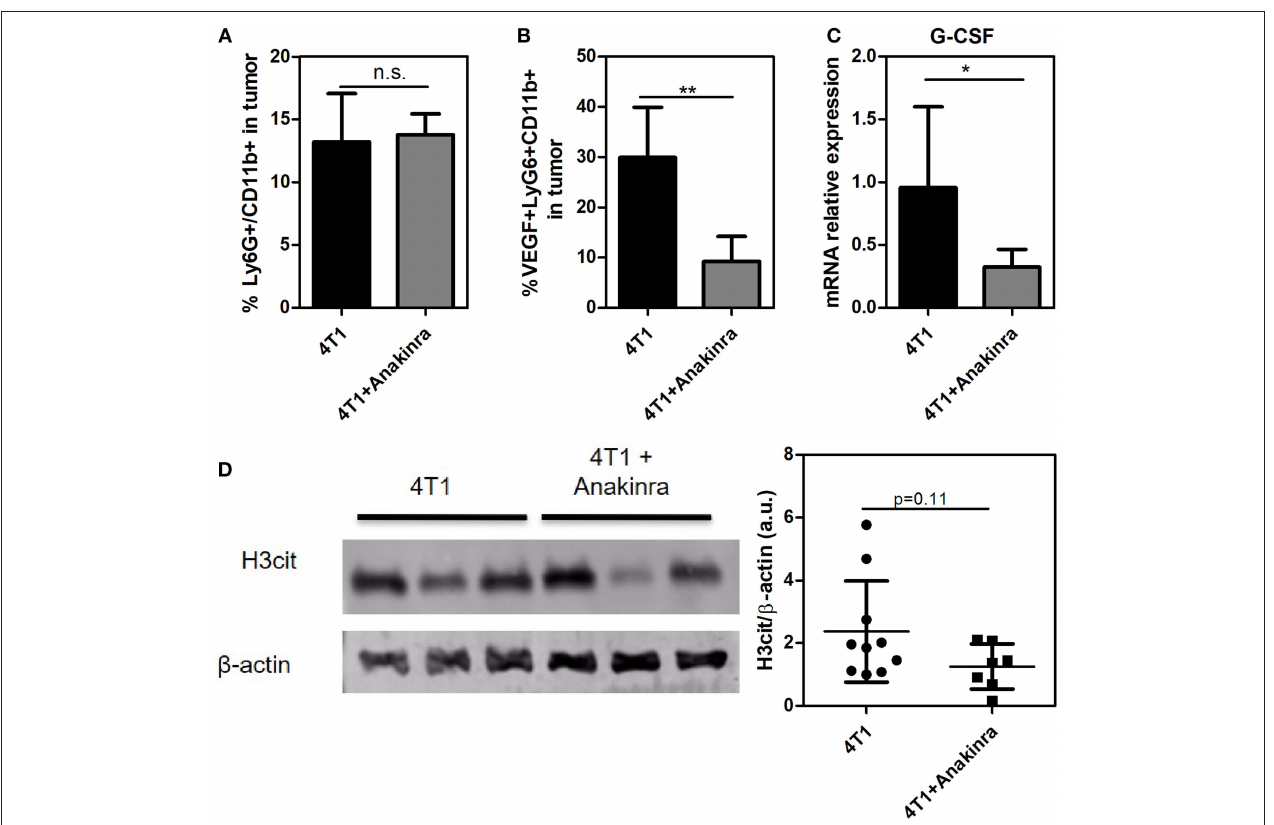
FIGURE 4 | Impact of blocking IL-1R in the 4T1 tumor microenvironment. Both 4T1 and 67NR tumor-bearing mice received anakinra (10 mg/kg/day, s.c.) for 8 between day 14 and day 21 after the tumor cell inoculation. (A) The infiltration of neutrophils into 4T1 ( n = 6) and anakinra-treated 4T1 ( n = 6) tumors was analyzed 21 days after the cell inoculation. The tumors were dissociated into single cells and assessed for Ly6G + CD11b + cells via flow cytometry. (B) The expression of VEGF in tumor-associated neutrophils in the 4T1 tumor (black bars, n = 4) or anakinra-treated 4T1 (gray bars, n = 6) tumors was assessed by VEGF expression in Ly6G + CD11b + cells. (C) The expression of the G-CSF gene was analyzed by qRT-PCR in tumor lysates from 4T1 (black bar, n = 6) and anakinra-treated 4T1 (gray bar, n = 6) tumors. β - actin was used as a reference gene for normalization. The relative expression level of the mRNA was calculated using the 11 CT method. (D) To evaluate the presence of NETs in the tumor microenvironment of mice treated with the IL-1R antagonist, the levels of citrullinated histone (H3cit) in 4T1 ( n = 10) and anakinra-treated 4T1 ( n = 7) tumors were investigated by western blotting. The right panel shows the quantification of the H3cit protein level normalized to that of β -actin. Each dot represents one individual mouse. Values represent the mean ± SD. * P < 0.05 and ** P = 0.01; n.s., non-significant, unpaired two-tailed Student’s t